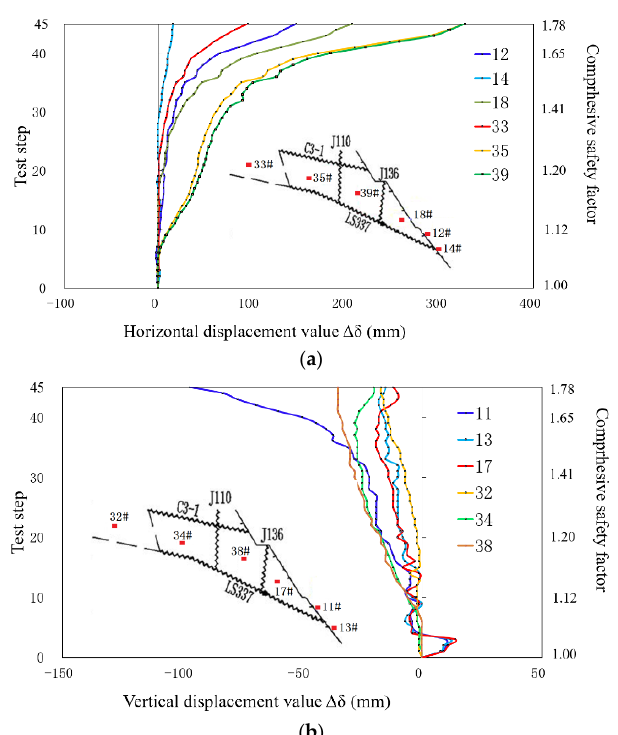
Figure 8. Typical curve of slope surface displacement (monitoring points near LS 337 ). ( a ) Horizontal displacement; ( b ) vertical displacement. Appl. Sci. 2020 , 10 , 1577